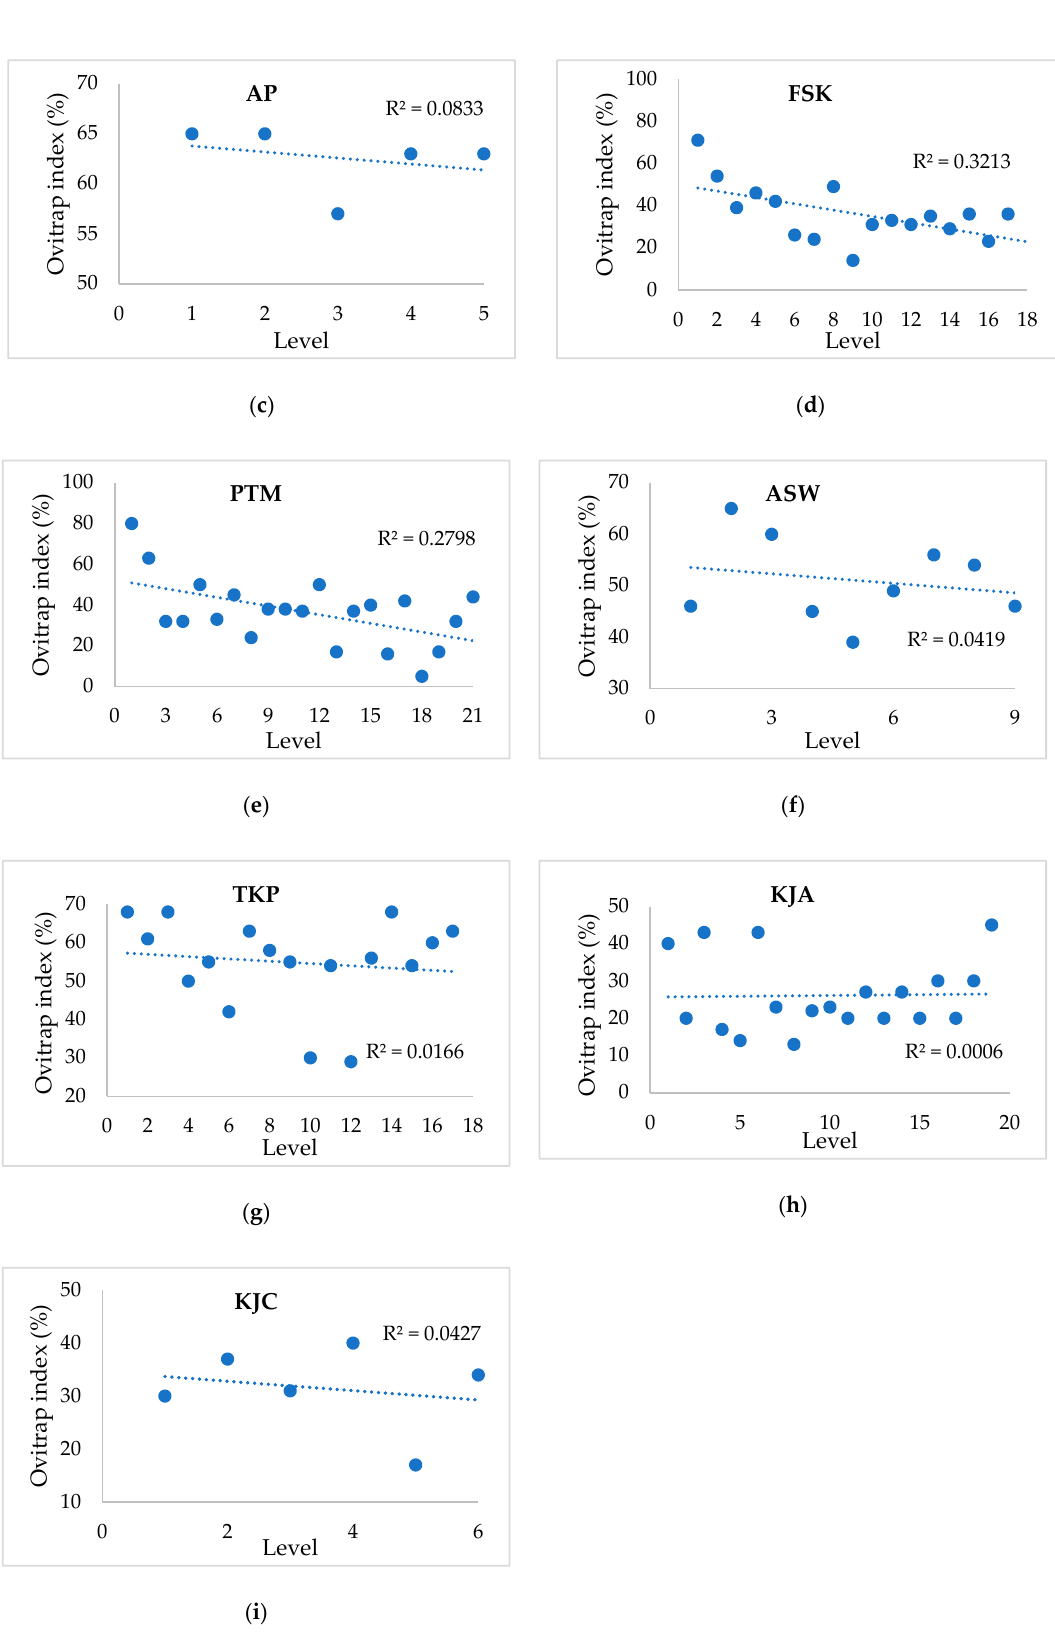
Figure 2. Relationship between ovitrap index (%) and level in each study site. ( a – i ) GC8, GC10, AP, FSK, PTM, ASW, TKP, KJA,